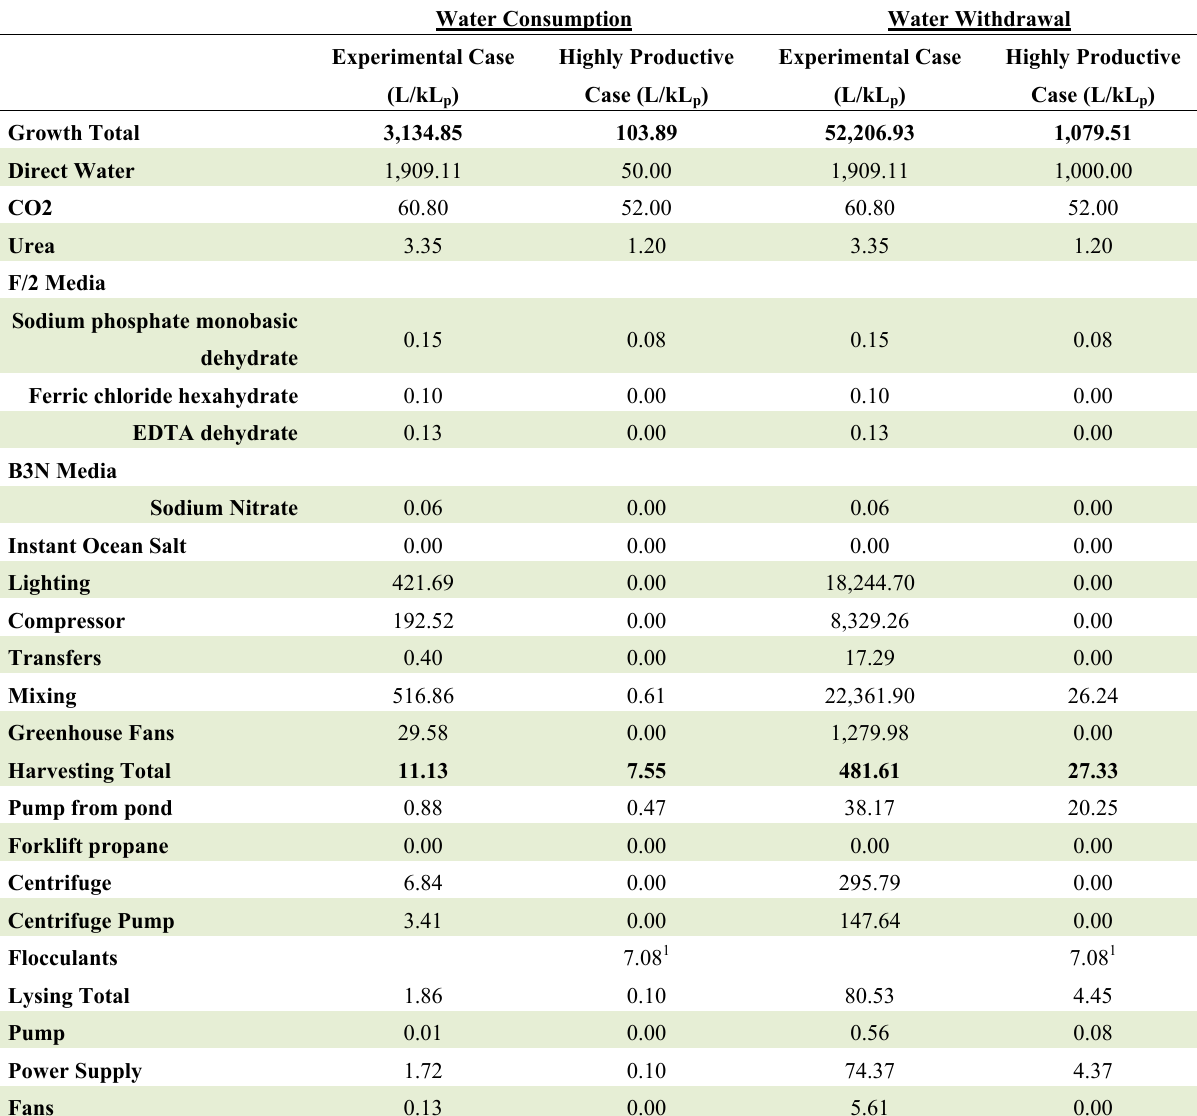
Table 5A. Water consumption and withdrawal summary for the Experimental Case a nd the Highly Productive Case